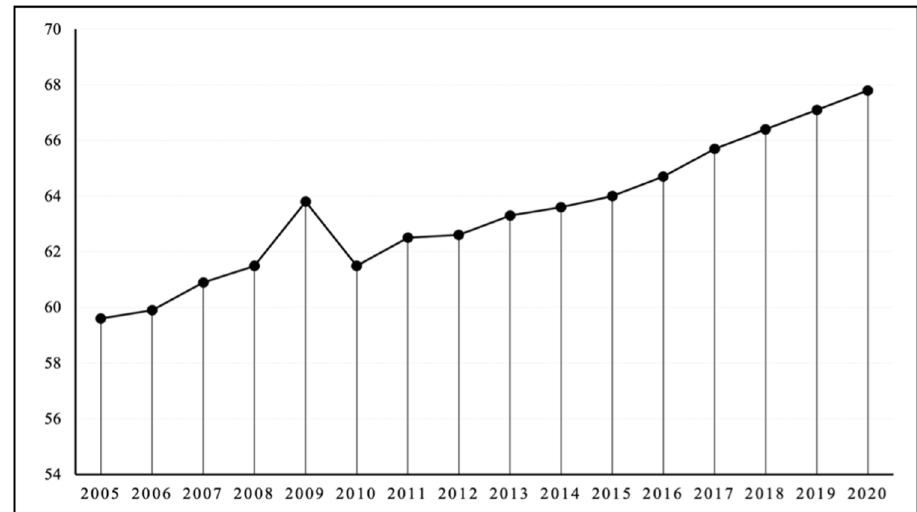
Figure 5. Hard-paved roads in Poland in 2005–2020 in % (own study, based on [45]). Transport exclusion has a negative impact on local communities: it generates addi- tional costs of maintaining an individual means of transport, contributes to the exclusion of some people from social and cultural life, and may also be a cause of unemployment or of a lack of access to public services.